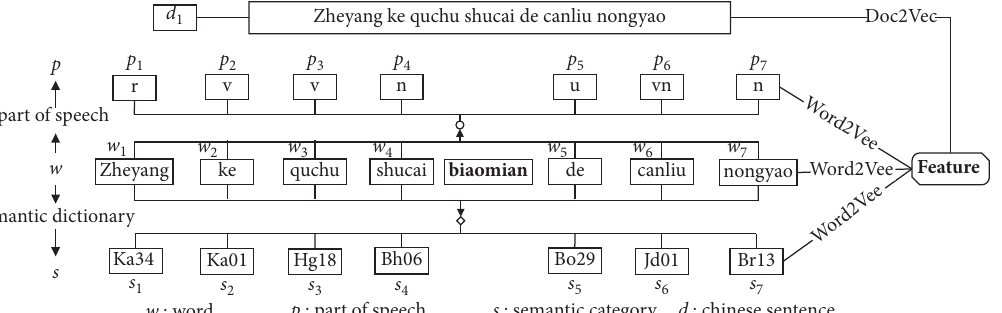
Figure 1: Feature